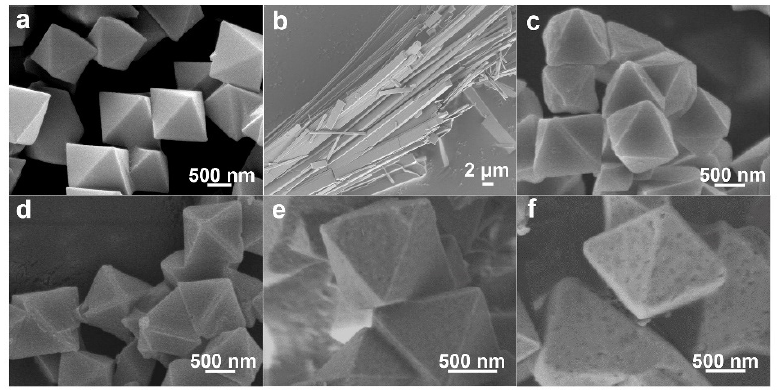
Figure 6. ( a , b ) SEM images of CuBTC ( a ) and CuBTC after submersion in water for 1 day ( b ); ( c – f ) SEM images of CuBTC@APTES-2 ( c ) and CuBTC@APTES-2 after submersion in water for 1 day ( d ), 3 days ( e ), and 5 days ( f ).